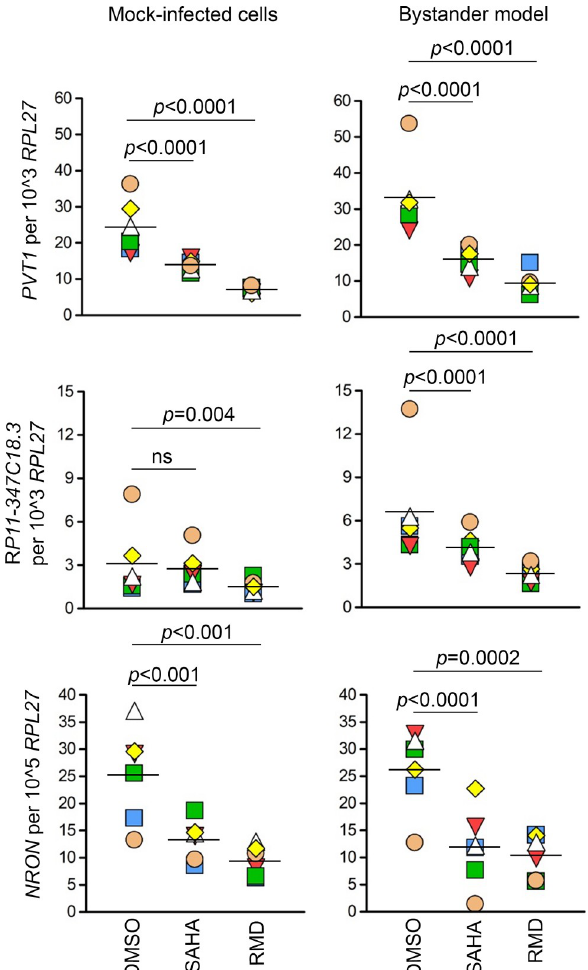
Fig 7. Down-regulation of PVT1 , RP11-347C18 . 3 and NRON by SAHA and RMD. Mock-infected cells and the bystander model of HIV latency were treated with SAHA (1 μ M), RMD (15 nM) or their solvent DMSO for 24 hours. Expression of lncRNAs was measured by ddPCR and normalized to expression of the housekeeping gene RPL27 . Six replicate experiments were performed. Significance was determined by implementing repeated measures analysis of variance (RM ANOVA) with library nlme in R using log 2 transformed data. Data is presented as individual data points (copy numbers normalized to RPL27 ) symbol-coded by donor, mean of all values is shown. DMSO , dimethyl sulfoxide; SAHA , suberoylanilide hydroxamic acid; RMD , Romidepsin; ns , not significant ( p -value > 0.05).